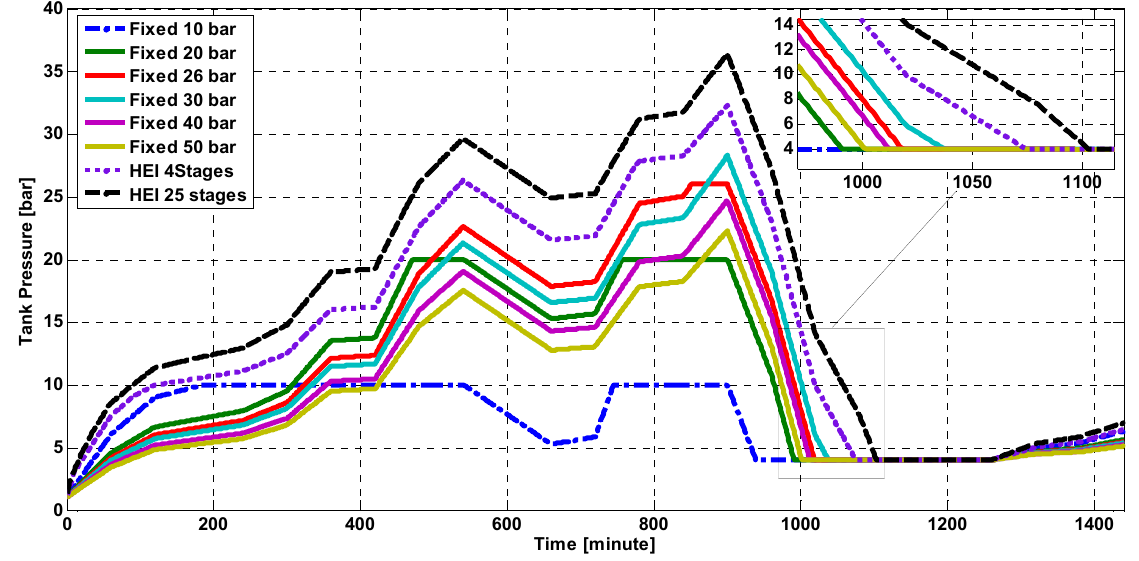
Figure 12. The tank pressure variation in different compression control strategies.